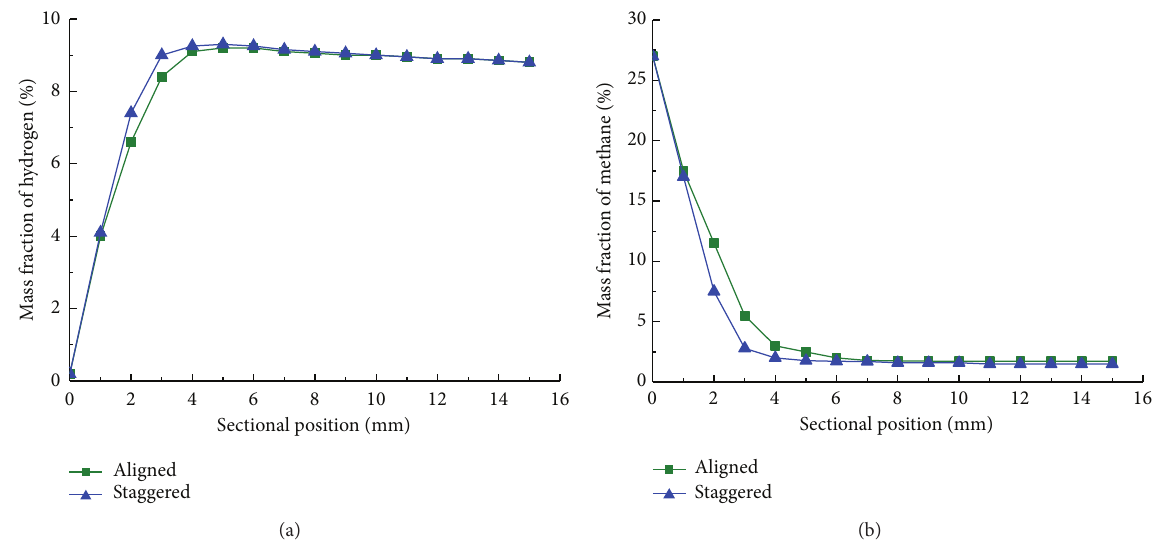
Figure 9: Mass fraction of (a) hydrogen and (b) methane along sectional position with aligned ( ◼ ) and staggered ( 󳵳 ) layout of cylinder: reaction time 𝑡 𝑟 = 25 s.